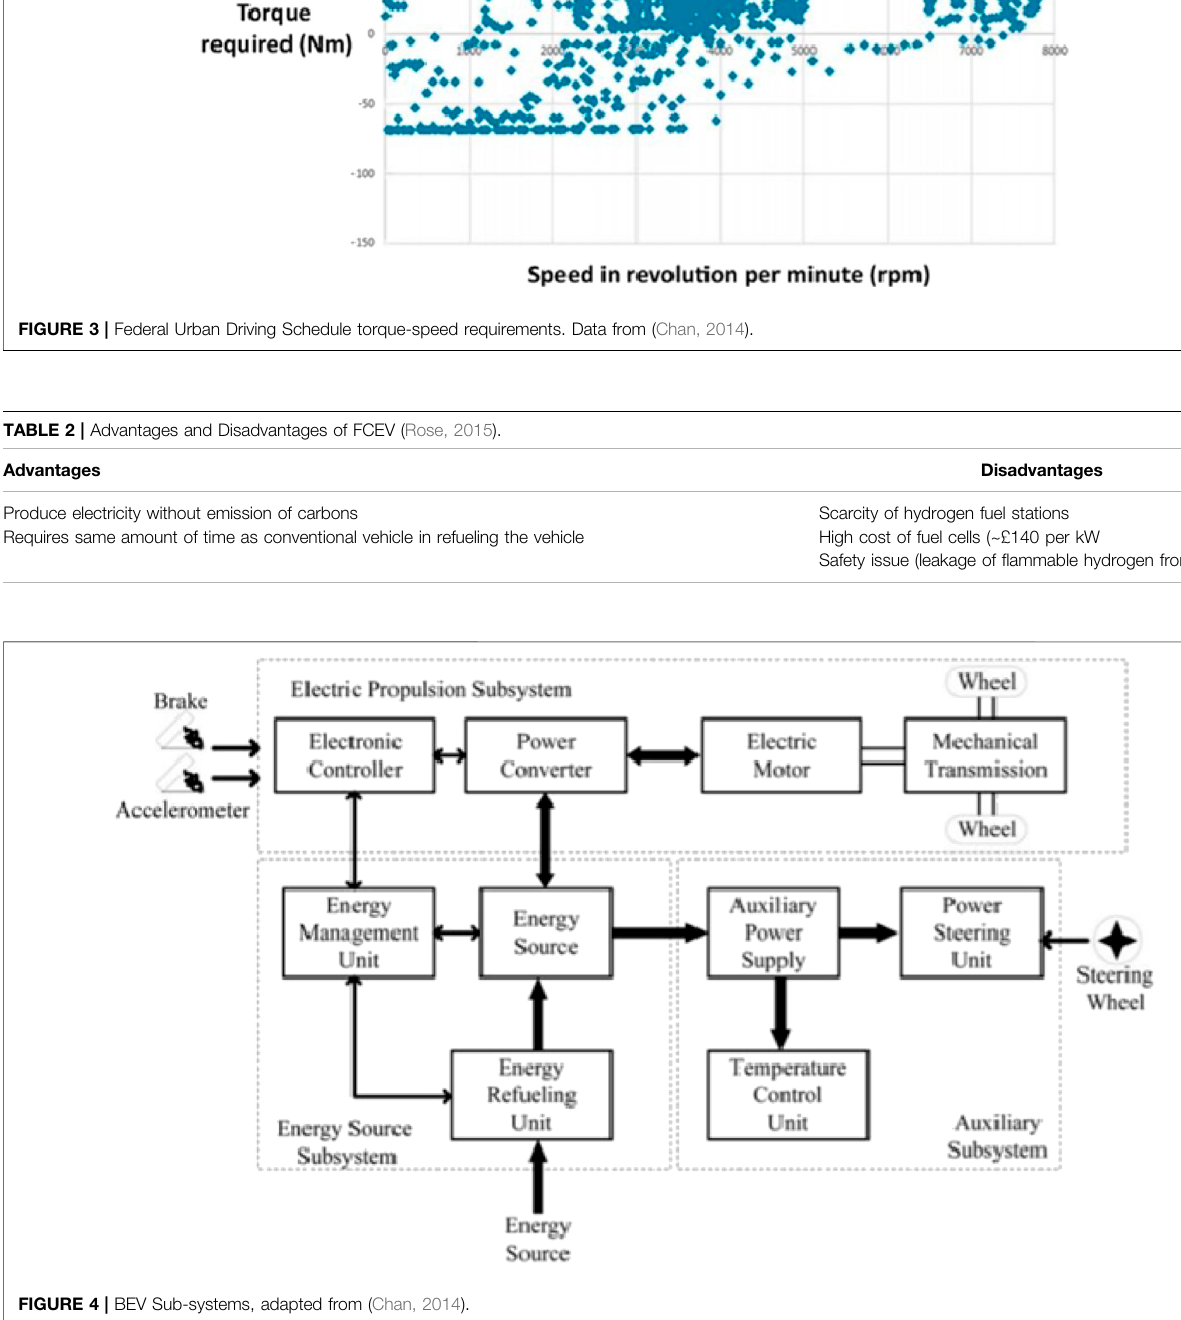
FIGURE 4 | BEV Sub-systems, adapted from (Chan,